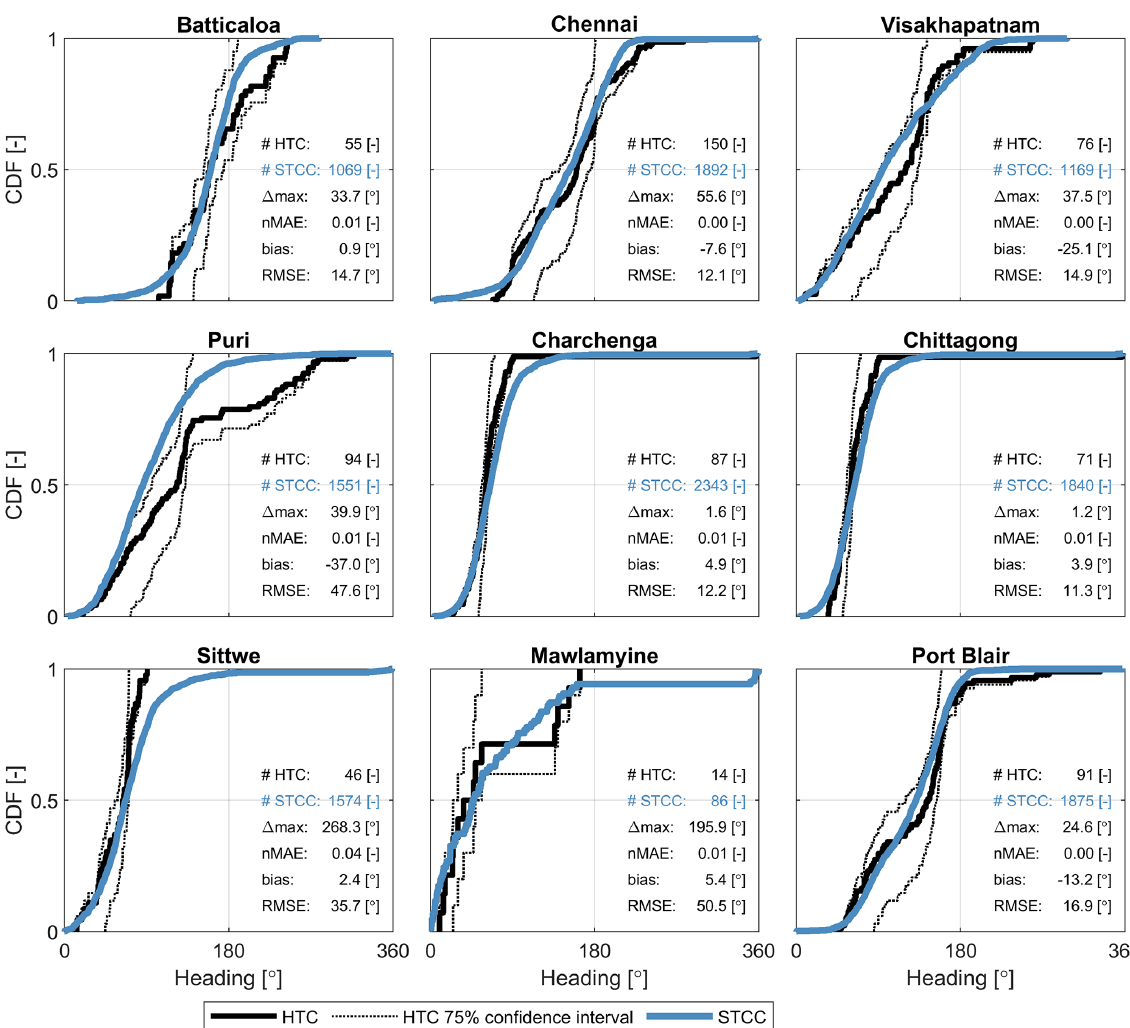
Figure B3. Comparison between CDFs of heading direction for HTCs (black line) with 75% confidence intervals (dashed line) and STCC (blue line) at nine locations along the Bay of Bengal. The functions are estimated based on TCs within a 200km radius of each location. The number of samples (time steps of a TC) within the 200km radius is indicated (#HTC and #STCC), alongside several statistical parameters comparing the HTC and STCC distributions (i.e., absolute difference in maxima ( (cid:49) max), normalized mean absolute error (nMAE), the relative bias of the median value (bias) and the root-mean-square error (RMSE) of the whole CDF. The nine locations are shown in Fig.